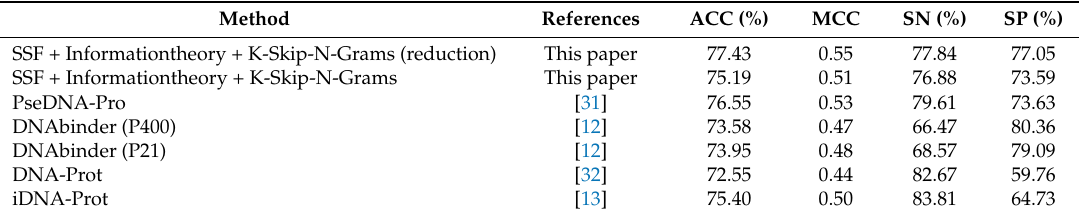
Table 3. Accuracy of existing feature representation methods using PDB1075 dataset.